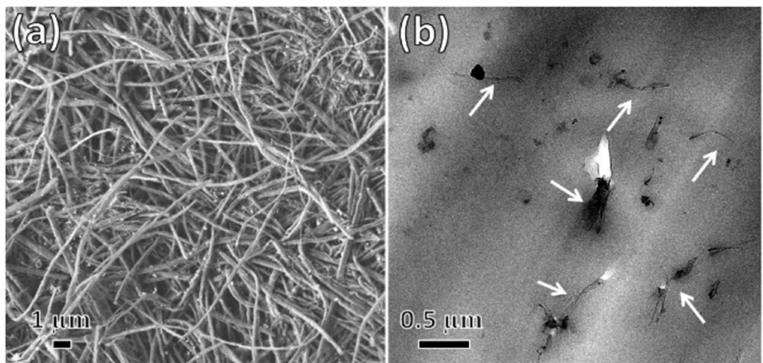
Figure 8. ( a ) SEM images of agglomerated edge-functionalized GNR and ( b ) TEM image of nanocom- posite loaded by 0.15 wt.% edge-functionalized GNRs (white arrows mark the individually dispersed GNRs) [95], reprinted with permission from Elsevier.